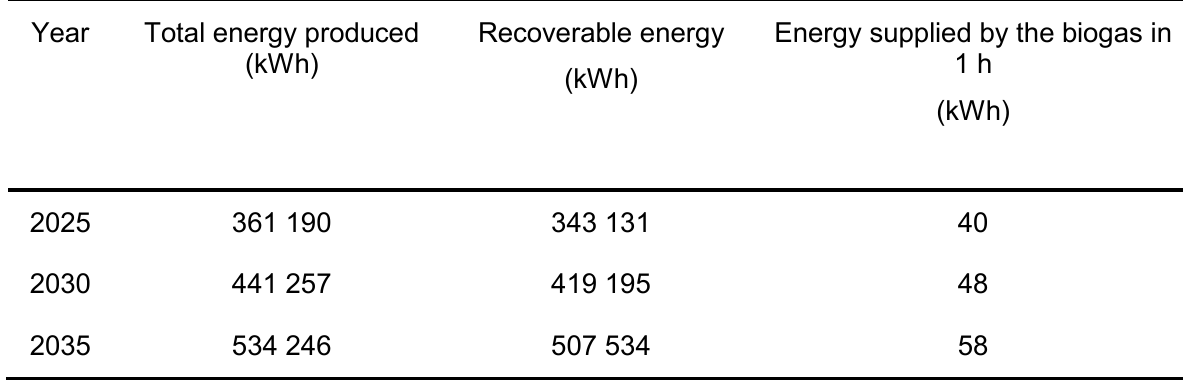
Table 2 . Quantity of energy produced, recoverable and